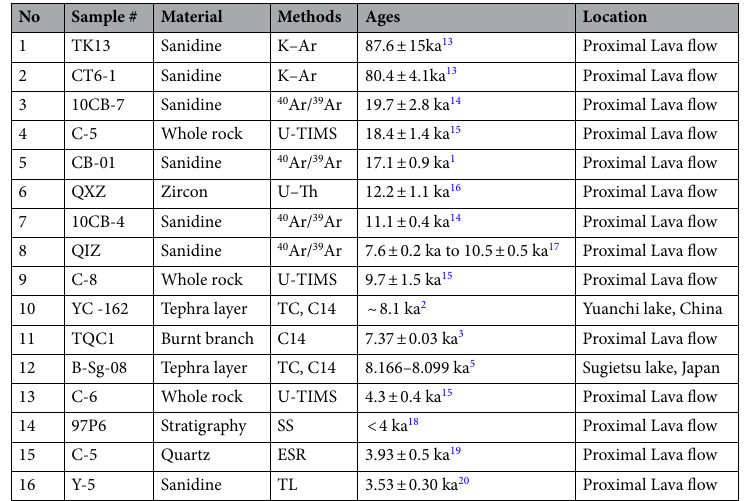
Table 1. Previous geochronological data for the Qixiangzhan eruption from the Changabaishan-Tianchi volcano. Ordered by age from old to young. C14-Radiocarbon dating; TL-Thermoluminescence; ESR-Electron Spin Resonance; U-TIMS-U series TIMS; TC-Tephrochronology; SS-Stratigraphy sequence.